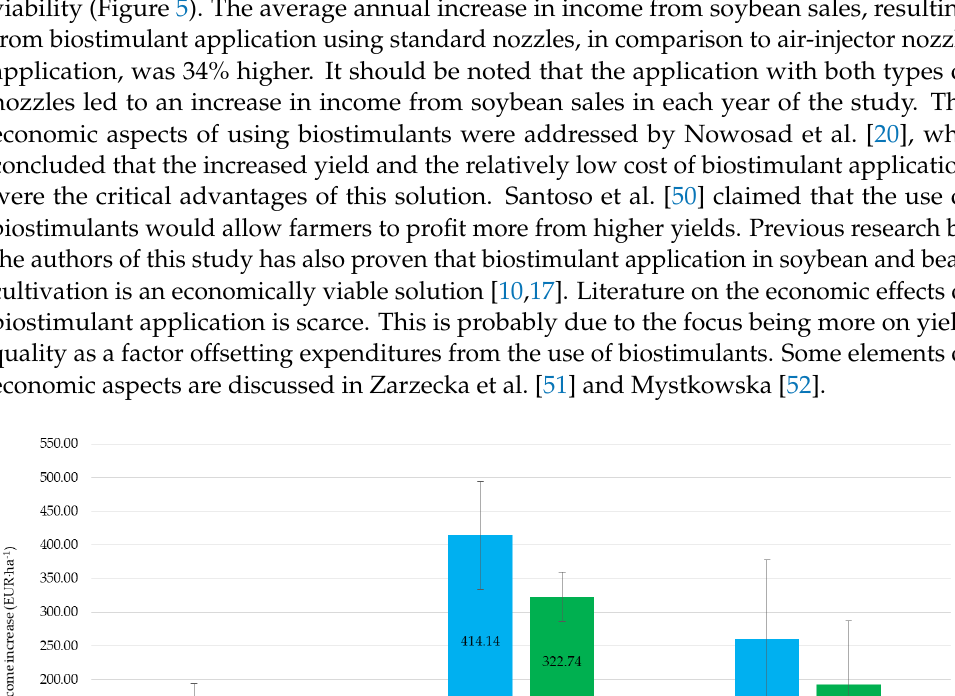
Table 3. Protein and fat content in soybean seeds (mean ± SD).